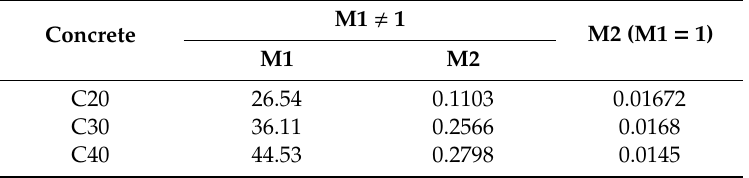
Table 8. Fitting goodness of the dynamic elastic modulus degradation model. Legend: SSE, sum of squares due to error; RMSE: root mean square error; R ‐ Square: coefficient of determination.